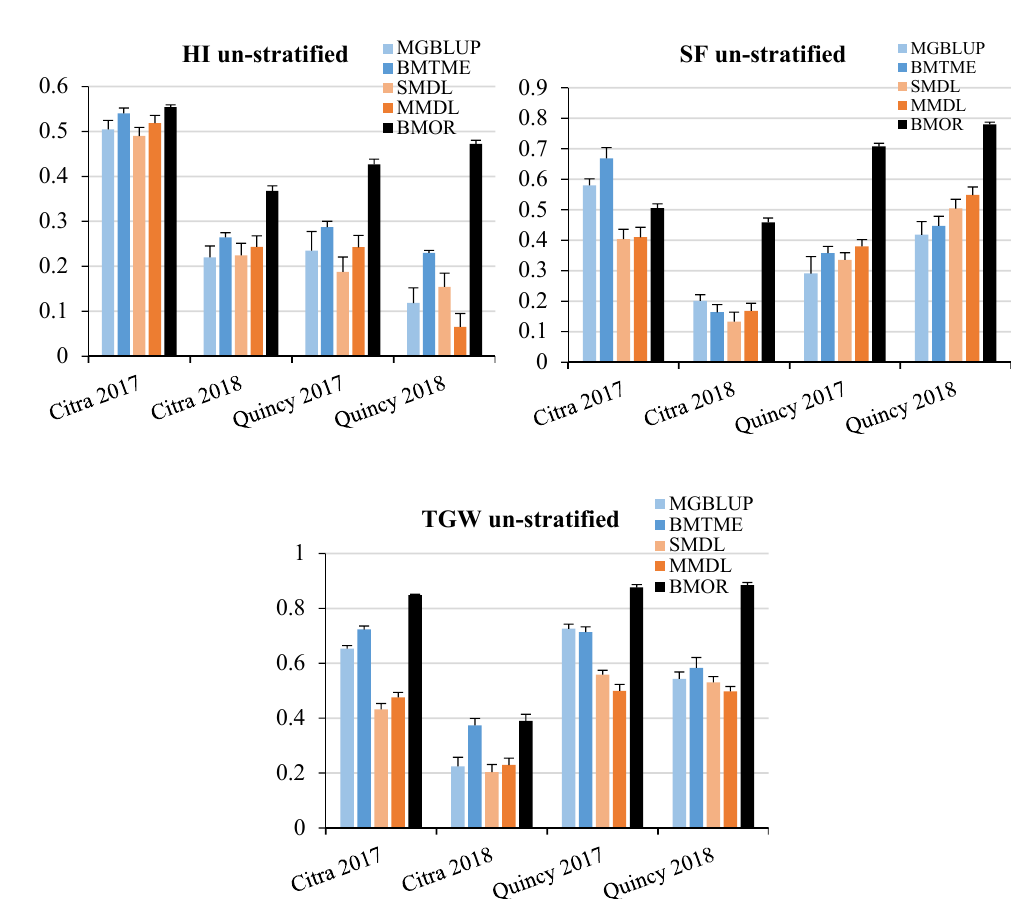
Figure 2. Prediction accuracies for GY, HI, SF, and TGW without population stratified. GY, grain yield; HI, harvest index; SF, spike fertility; TGW, thousand grain weight. Mean Pearson’s correlations and standard errors for each environment were presented for each trait. Statistical models were colored in light blue and blue while DL models were colored in light orange and orange. The Bayesian Multi-output Regressor (BMOR) model was colored in black.